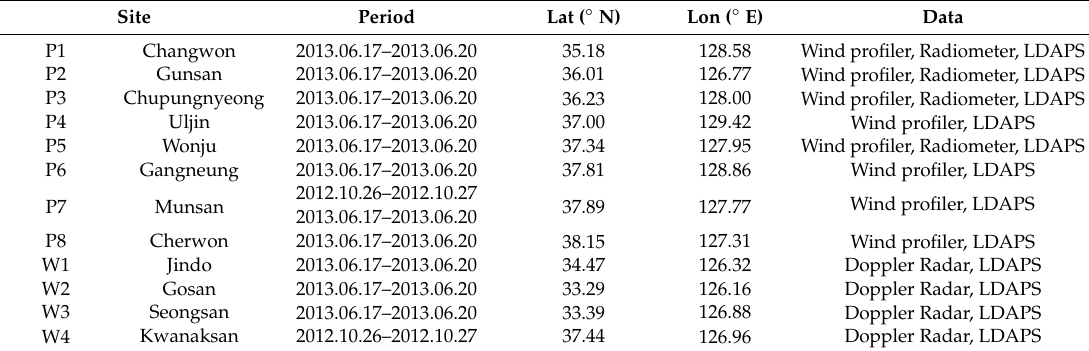
Table 2. Observation periods and